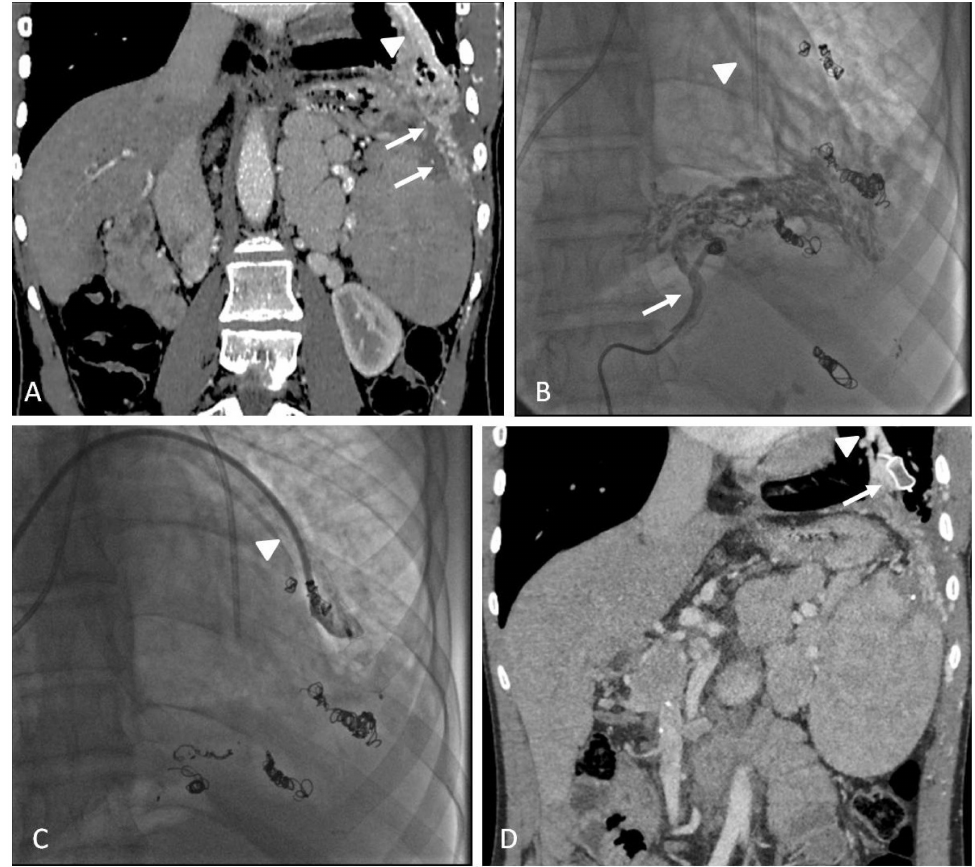
Figure 5. Combined transarterial and transvenous transcatheter coil and plug embolization of a complex iatrogenic high-flow vascular malformation with systemic to pulmonary shunt in a 17-year- old male. A large left diaphragmatic high-flow vascular malformation developed after iatrogenic splenic infarction and abscess. ( A ) Reformatted coronal Computed Tomography Angiography (CTA) image shows the vascular malformation (arrows) fed by several arteries, among which intercostal, lumbar, diaphragmatic, and left gastric, draining into the left inferior pulmonary vein (arrowhead). The presence of a direct shunt with the pulmonary vein did not allow us to inject liquid embolics and particles in the afferent arteries, due to the risk of non-target cerebrovascular and systemic embolization. ( B , C ) Fluoroscopic images show the complete evaluation of the inflow and outflow of the malformation, realized through direct transarterial catheterization (arrow) and transeptal US-guided puncture of the heart to select the left inferior pulmonary vein (arrowheads); embolization of the arteries was performed with several metallic coils and plugs. ( D ) Reformatted coronal CTA image shows the plug (arrow) in the left inferior pulmonary vein (arrowhead) with reduced